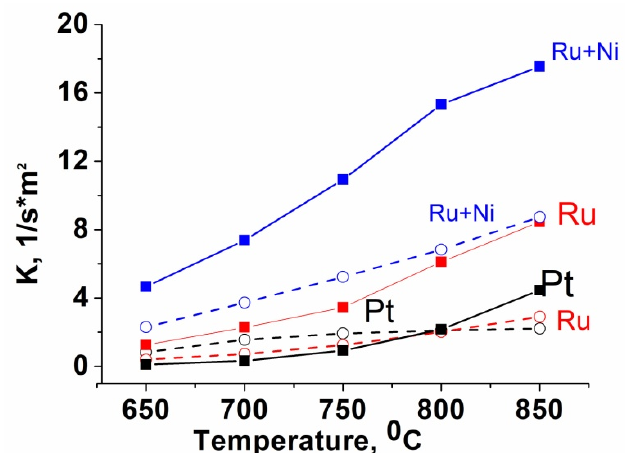
Figure 2. Specific rate constants temperature dependence for methane dry reforming on metal -supported SmPrCeZrO (filled symbols) and PrCeZrO (empty symbols) catalysts. Feed 7% CH 4 +7% CO 2 in He. Table 2. Kinetic parameters of MDR and oxygen mobility for catalysts prepared in supercritical conditions [24].